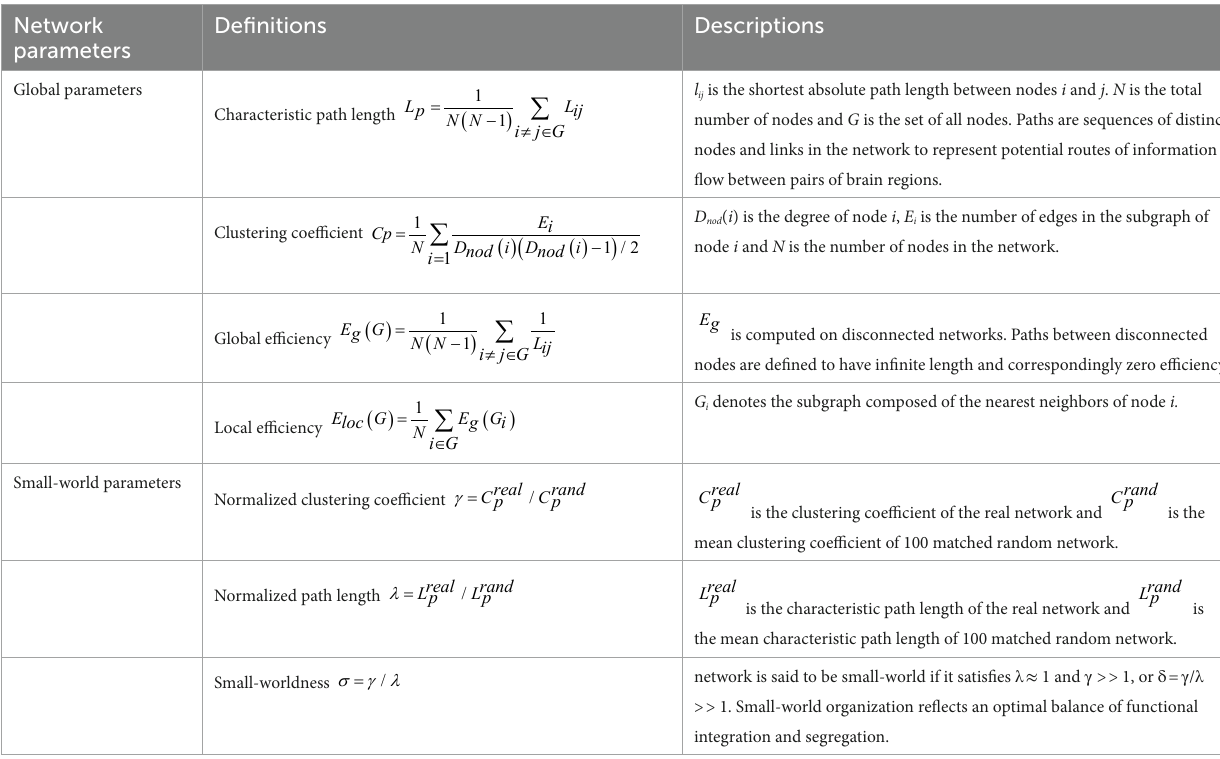
TABLE 1 The mathematical definitions and descriptions of global and small-world parameters. Network